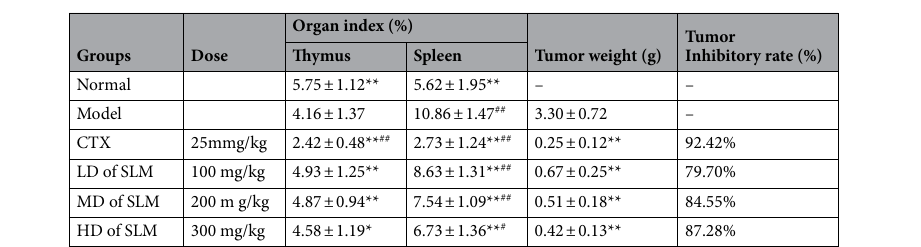
Table 2. Effect of EPA on tumor weights and tumor inhibition rate. The values are presented as mean ± SD. n =10, *p < 0.05, **p < 0.01 compared with the Normal group, #p < 0.05, ##p < 0.01 compared with the Model